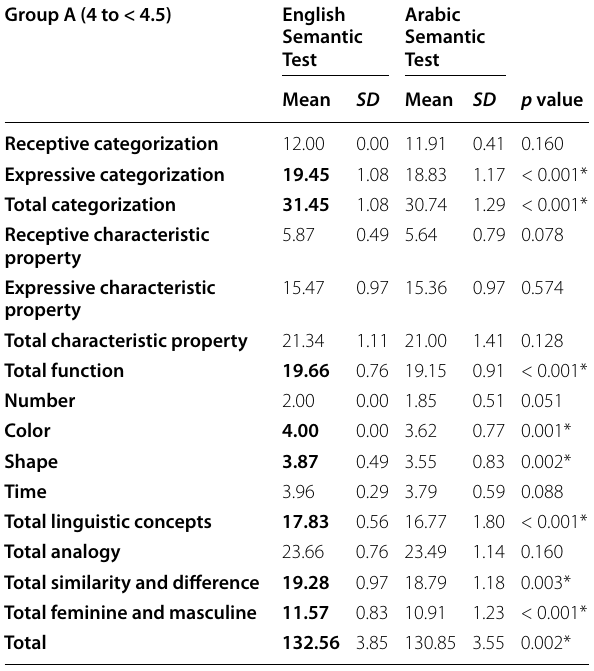
SD standard deviation, bold: higher value, *significant p value < 0.05